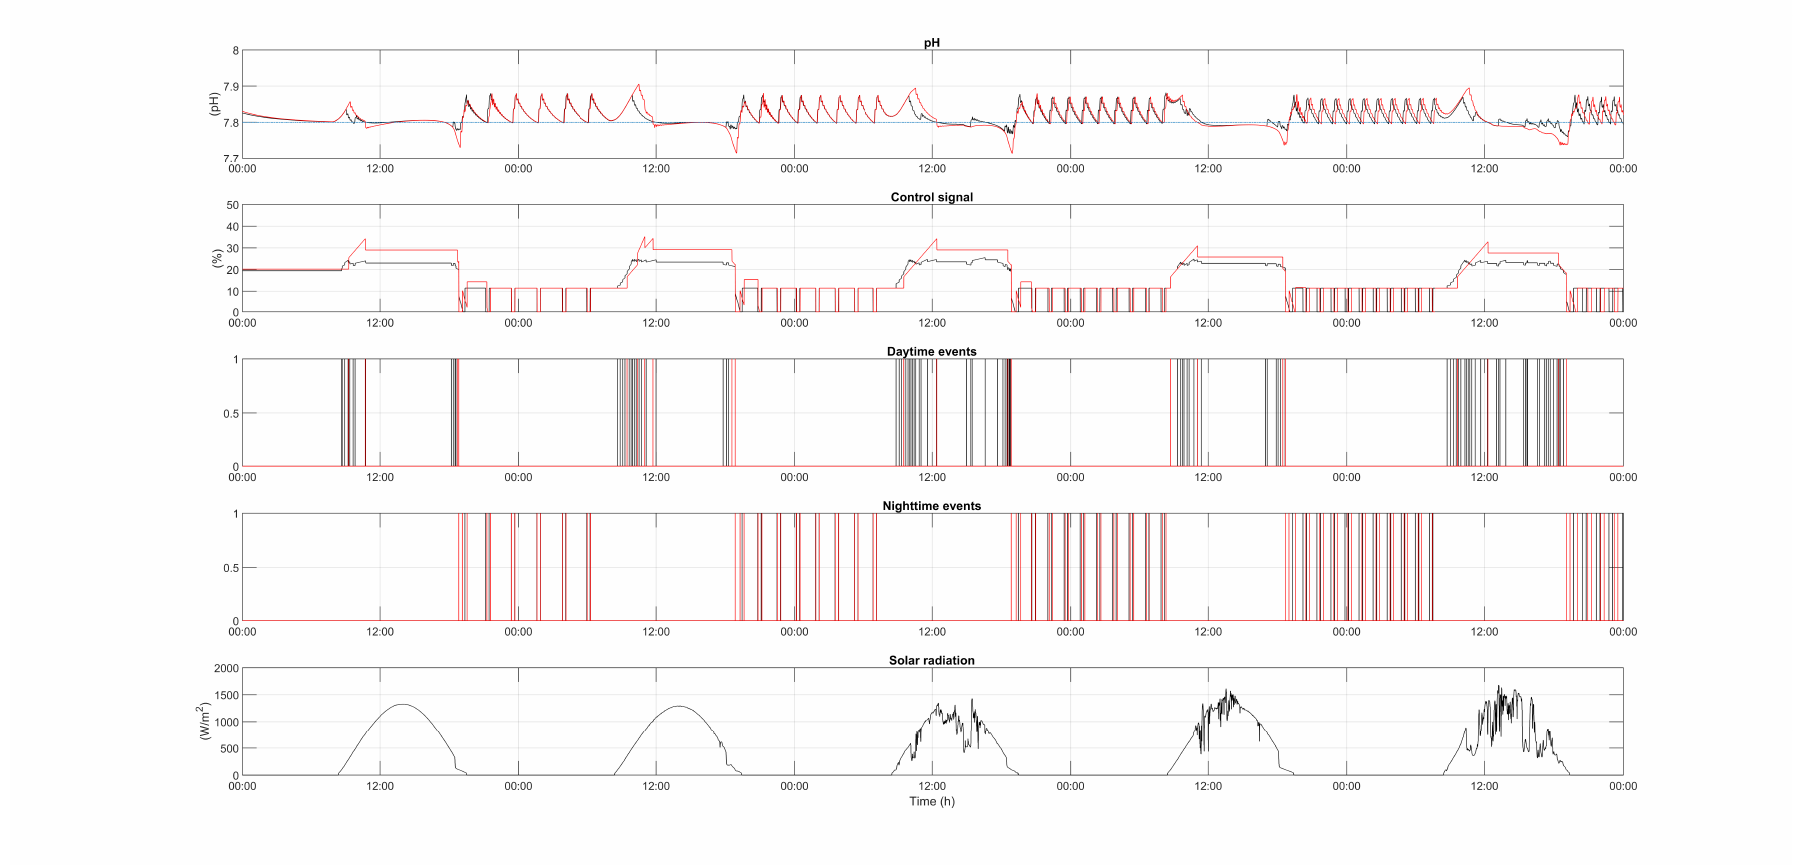
Figure 6. Results with the SSOD-PI controller. ∆ = 0.01 (black) and ∆ = 0.05 (red). First plot: pH output. Second plot: control signal. Third plot: diurnal events. Fourth plot: nocturnal events. Fifth plot: solar